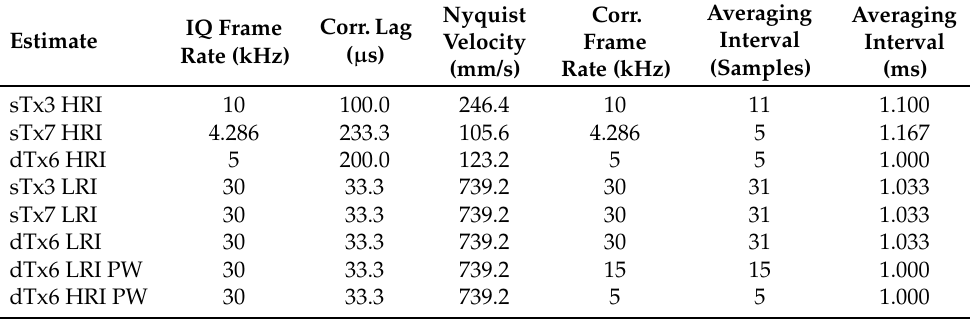
Table 2. The relevant slow-time quantities are given below. Note that in the case of the pairwise (PW) estimates in the last two rows the correlation frame rate differs from the in-phase and quadrature (IQ) frame rate. This is a characteristic of the pairwise estimation schemes. sTx3: three-angle single